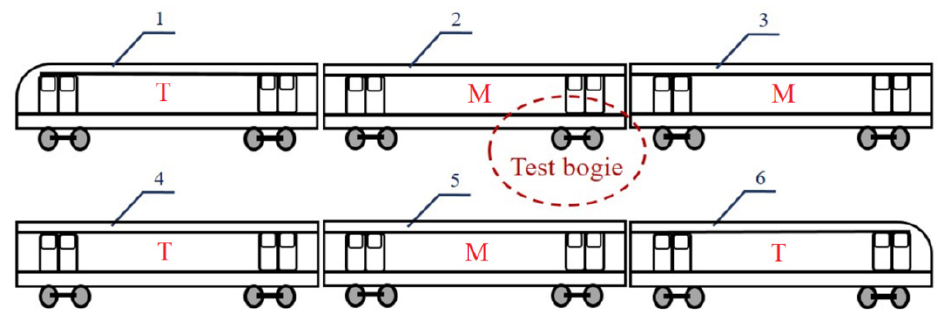
Figure 8. Test bogie location in the 6 ‐ car metro train (T: trailer car; M: motor car).